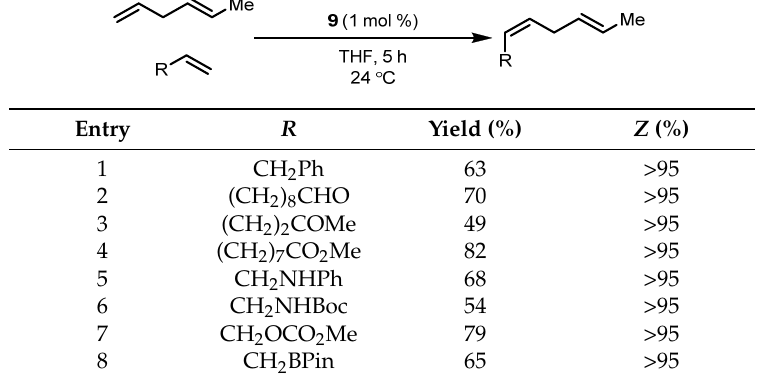
Table 7. Chemoselective CM with trans -1,4-hexadiene using 9 .